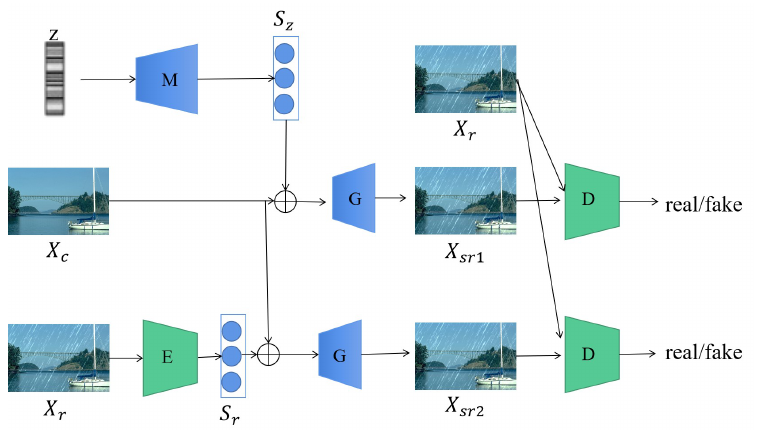
Figure 4. SyRaGAN network structure overview [24]. M is the feature extracting module, E is the encoder, and D are the discriminators. The inputs are clean background image x c and rain image x r , and the outputs are the synthesizing rain images x sr 1 , . . . , x sr 2 . Further, S z , S r are the extracted rain patterns from the network.